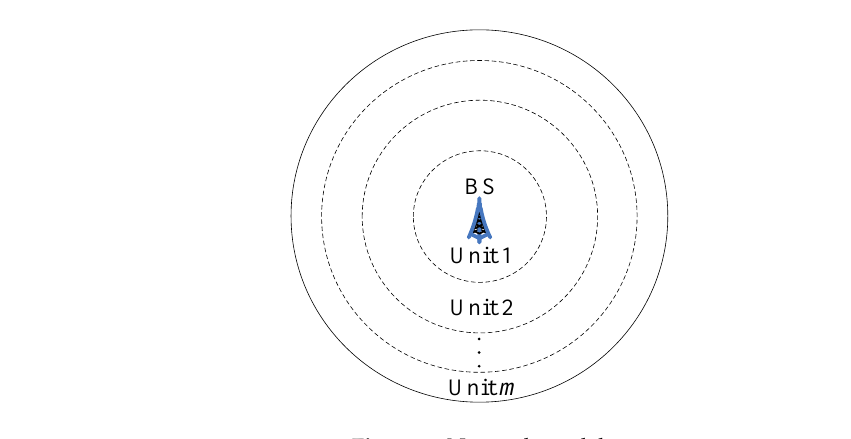
Figure 1. Network deployment scenario.